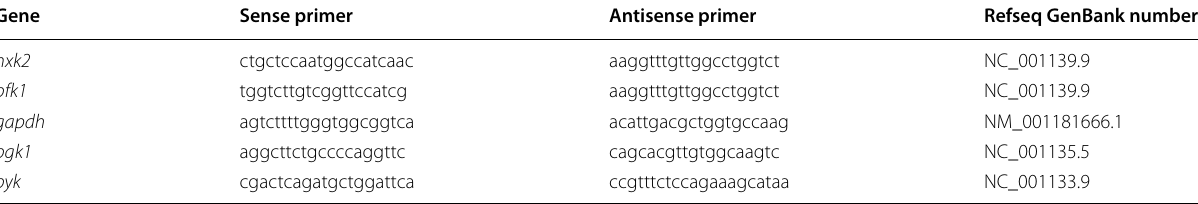
Table 2 The primers used in QPCR analyses of the expression of glycolytic genes in this